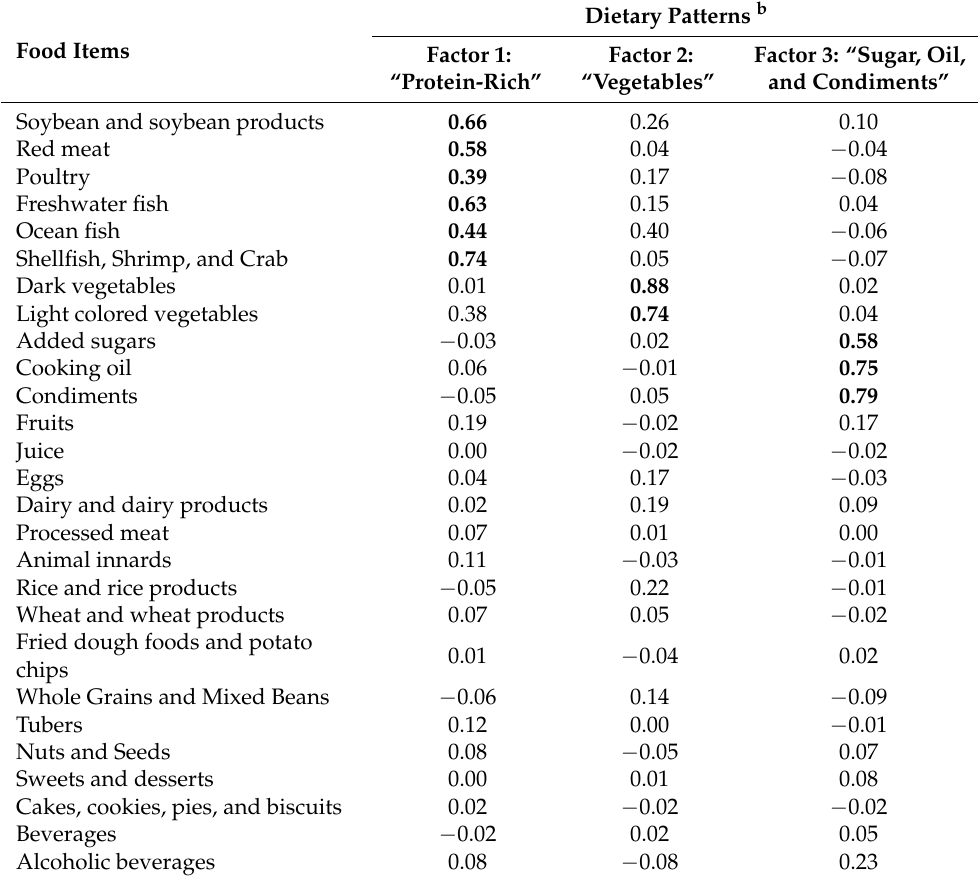
Table 1. Factor loadings to determine the association between food groups and factors representing dietary patterns a .